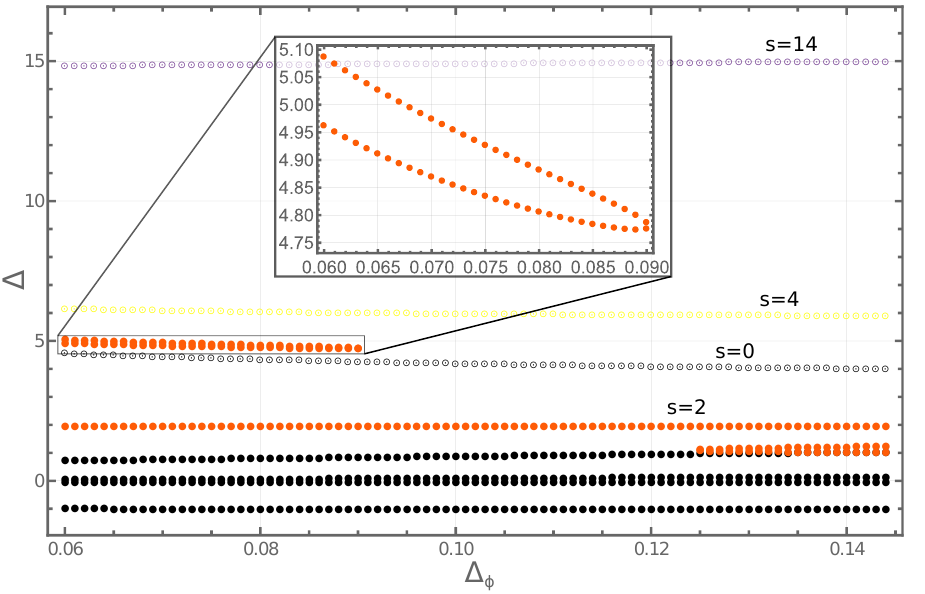
Figure 6 . Roots of the extremal functional evaluated for decreasing ∆ φ . Single roots are denoted by filled circles and double roots are denoted by dotted circles. The inlay plot shows the appearance of the pair single zeros at spin